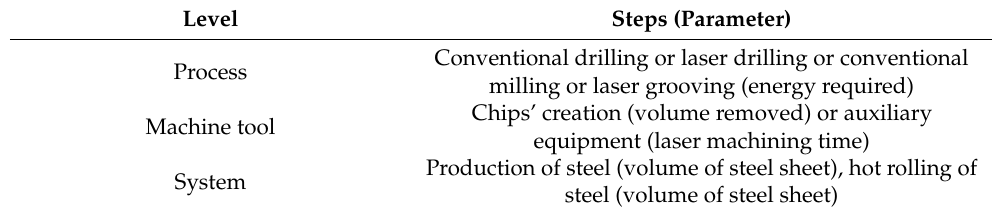
Table 1. Allocation of assumed steps for all cases per manufacturing level, where the process focuses on the manufacturing approach, machine tool refers to the auxiliary equipment or consumption of materials or tools, the system level includes production, disposal, and transport of resources at the production line level or factory level or even in a larger ecosystem depending on the boundary conditions of the life cycle